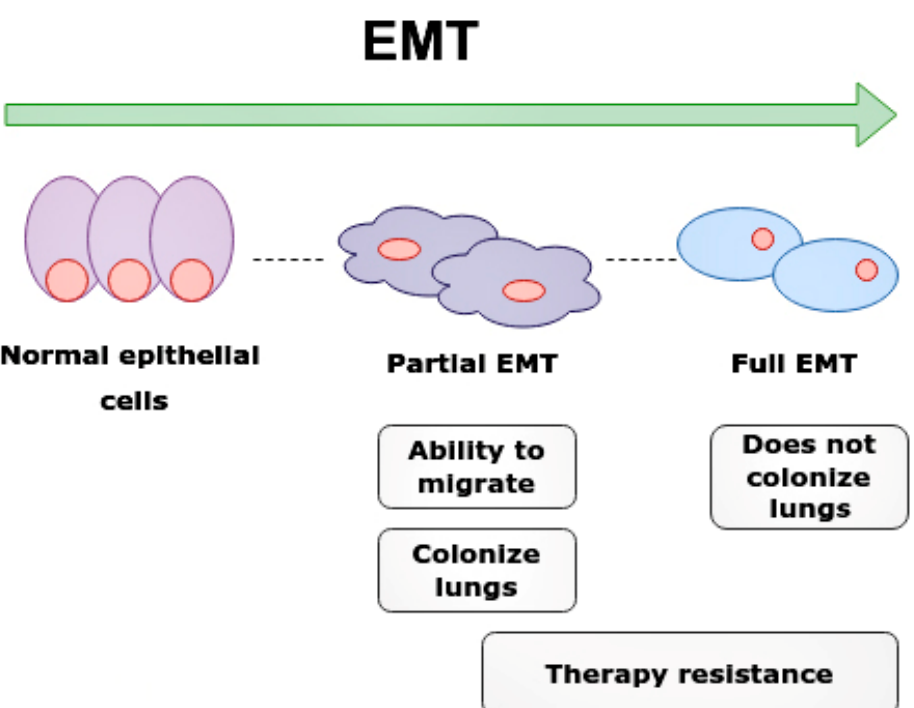
Figure 7. Epithelial-mesenchymal transition (EMT) and clinical significance of partial EMT and full EMT. Cells undergoing partial EMT have an ability to migrate and colonize lungs. Cell in full EMT do not colonize lungs. Therapy resistance is characteristic of both partial EMT and full EMT.